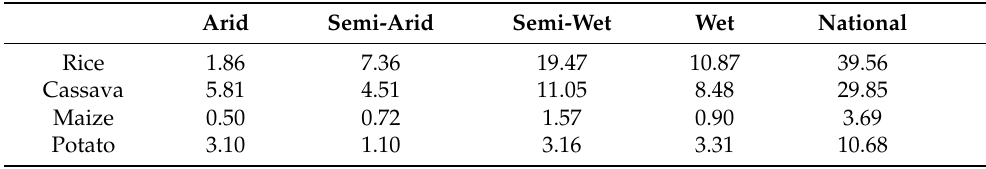
Table 1. The average production (in tonnes × 10 5 ) of rice, cassava, maize, and sweet potatoes in each climate-zone and nationally from